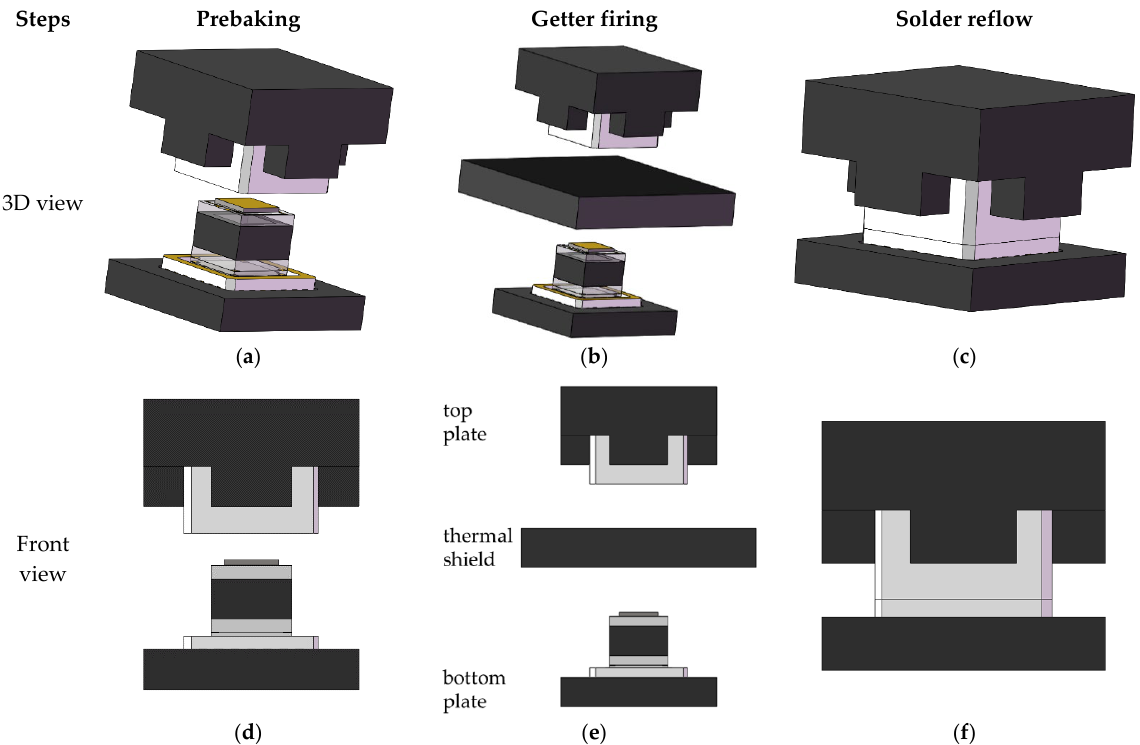
Figure 9. The configuration of ceramic shell and LCC during vacuum sealing. ( a ) the 3D view of Part C accommodated by bottom plate and ceramic shell loaded on the top plate during prebaking; ( b ) the 3D view of ceramic shell and Part C are separated by a thermal shield during getter firing; ( c ) the 3D view of ceramic shell is pushed down to the LCC of part C during solder reflow; ( d ) the front view of LCC accommodated by bottom plate and ceramic shell loaded on the top plate during prebaking; ( e ) the front view of configuration of ceramic shell and Part C during getter firing; ( f ) the front view of configuration of ceramic shell and Part C during solder reflow.